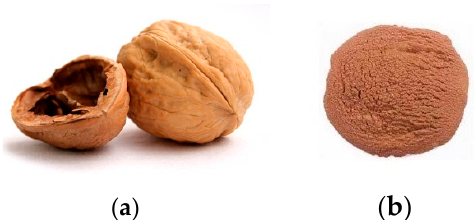
Figure 2. Raw agricultural residue: ( a ) walnut shell in hemispherical shape and ( b ) walnut shell powder. Table 1 shows the composition and elemental analysis for walnut